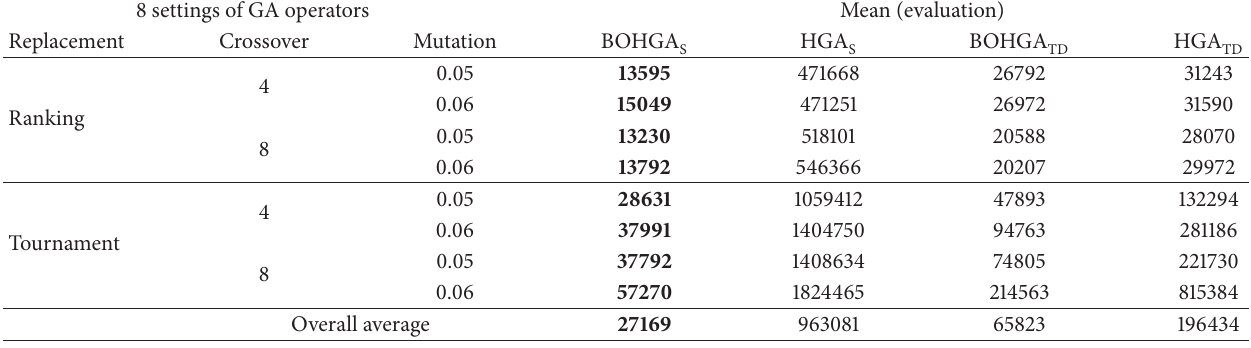
Table 2: Comparisons of BOHGA S , HGA S , BOHGA TD , and HGA TD in terms of mean of the number of evaluations under the eight settings of GA operators for the Schwefel’s function in 20 dimensions by stopping rule 1.